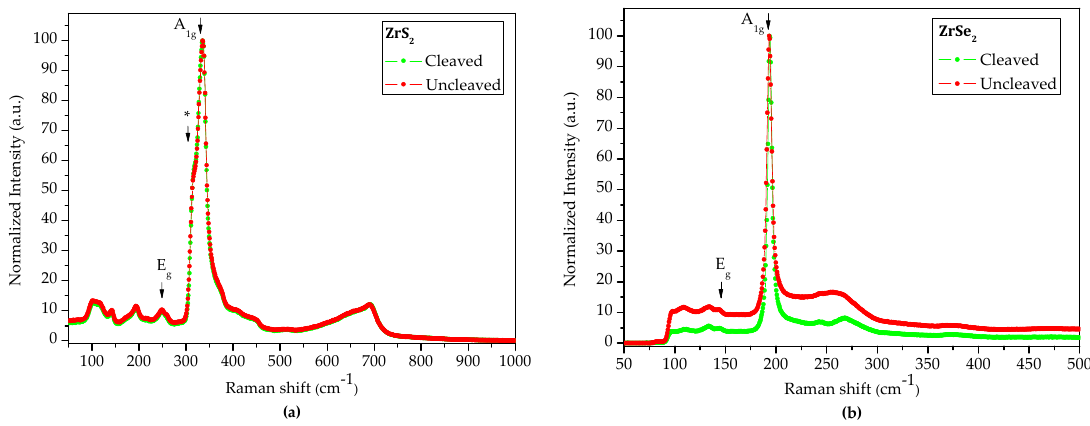
Figure C7. Raman spectra for freshly cleaved and uncleaved bulk crystals of ( a ) ZrS 2 ( λ = 532 nm) and ( b ) ZrSe 2 ( λ = 638 nm). The intensity has been normalized to the height of the A 1g peak. The Raman modes A 1g and E g are labeled. For ZrS 2 , the shoulder marked with “*” is attributed to a broadening of the A 1g peak due to non ‐ harmonic effects.